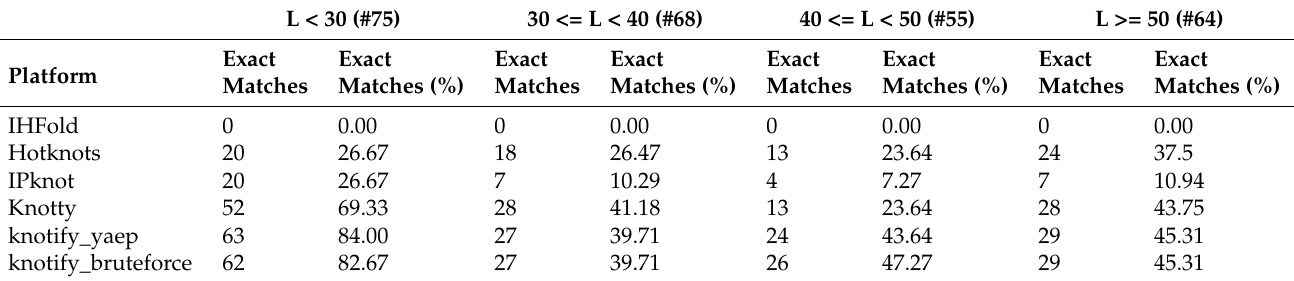
Table 4. Predicting pseudoknot location per RNA sequence